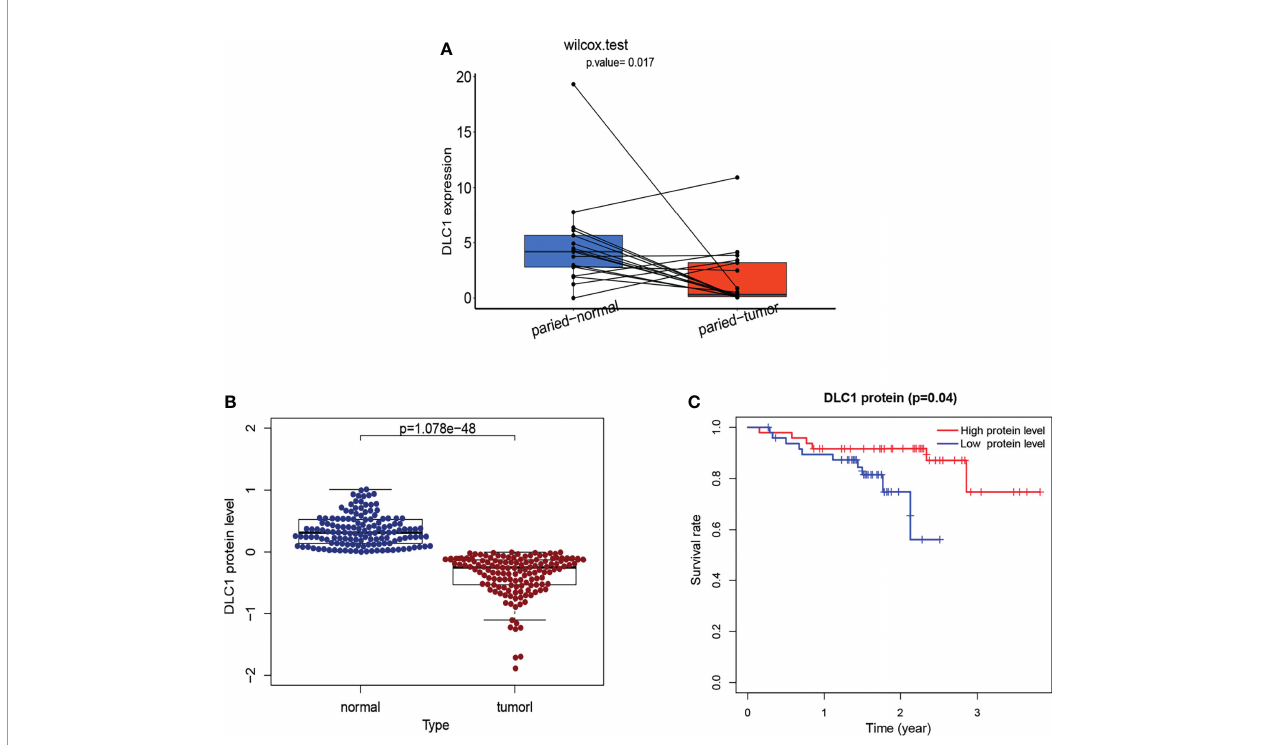
FIGURE 8 | Validation of the target gene by RT-qPCR analysis and validation of DLC1 protein expression based on a dataset from cBioPortal. (A) Tumor tissues and paired normal tissues were derived from 17 patients with EC, and Wilcoxon signed-rank test was used for evaluating the statistical signi fi cance of differences. (B) Relationship between DLC1 protein expression and prognosis of EC in the cBioPortal database. Patients were divided into high-target protein expression or low-target protein expression group depending on the comparison with the median expression level using the log-rank test. (C) DLC1 protein expression in the normal and tumor samples. Analyses were performed across all normal and tumor samples with P -value close to zero using the Wilcoxon rank-sum